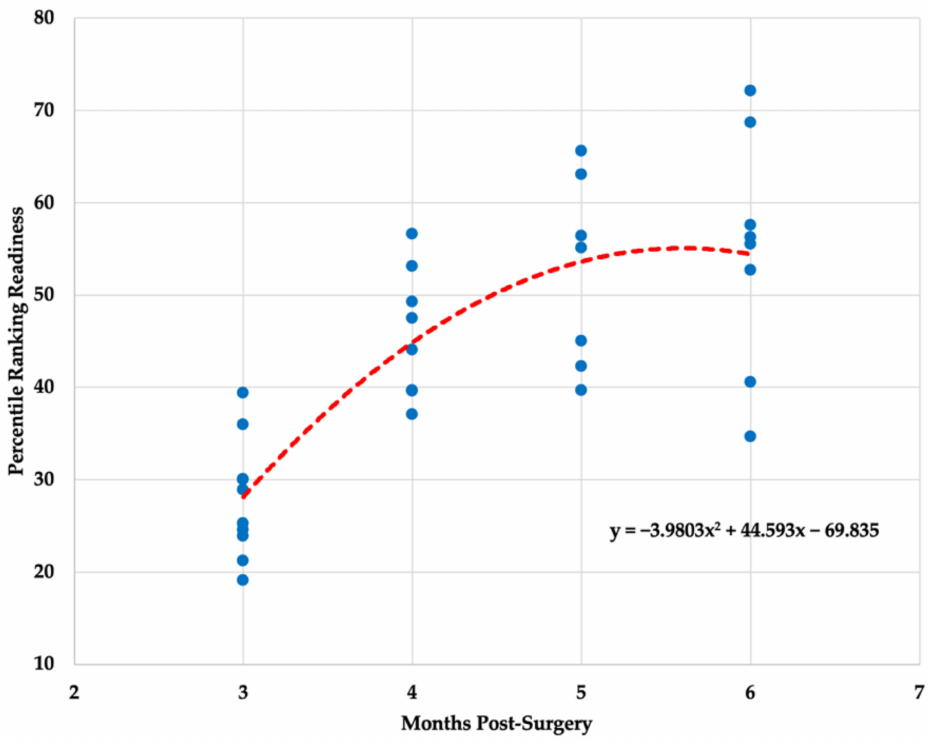
Figure 3. Polynomial regression model for readiness